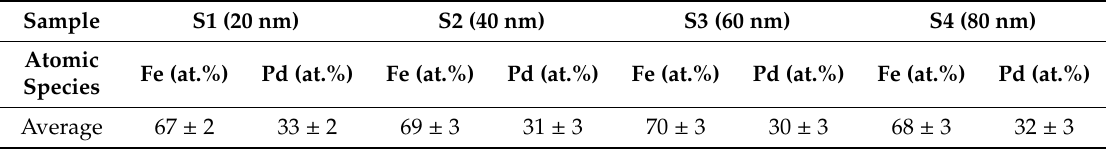
Table 1. Atomic percentage of Fe and Pd elemental composition in Fe–Pd thin films with di ff erent layer